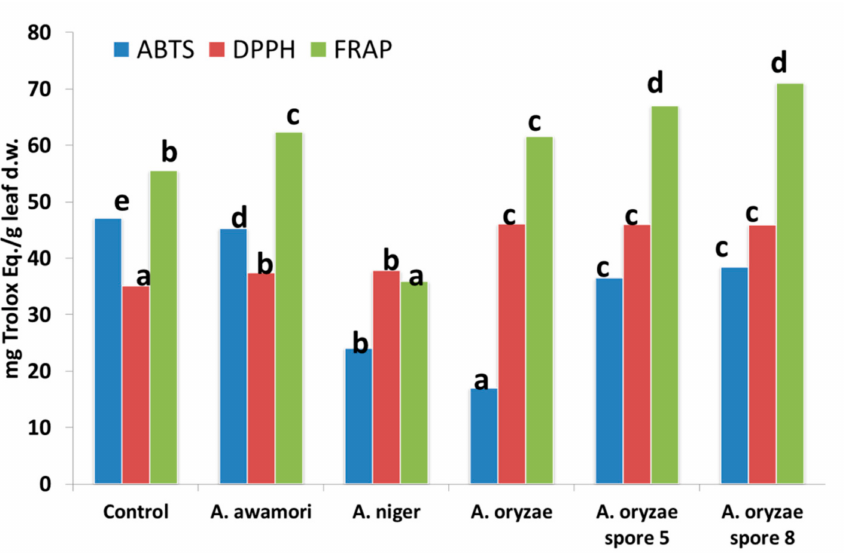
Figure 4. Antioxidant activity (mg Trolox equivalent/g leaf d.w.) of analysed samples. Different letters in the same raw indicate statistical differences ( p <